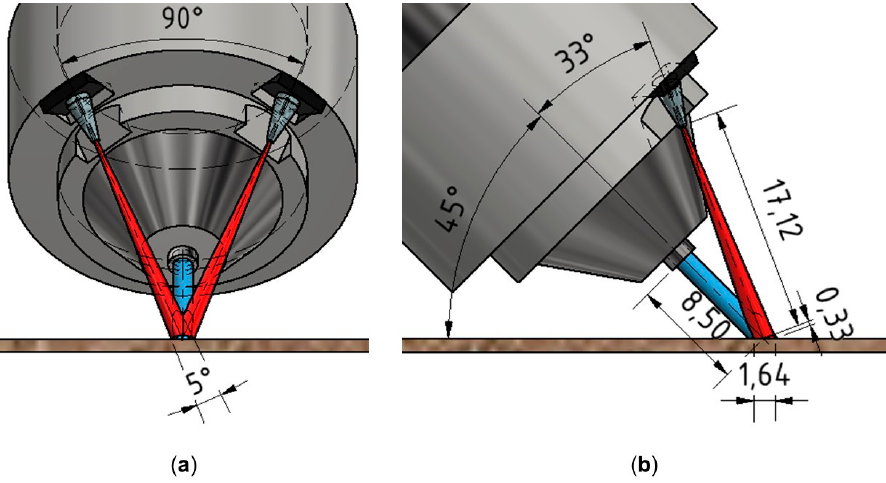
Figure 3. Concept of sensors: ( a ) front view, ( b ) side view; blue: visible plasma effluent, red: laser